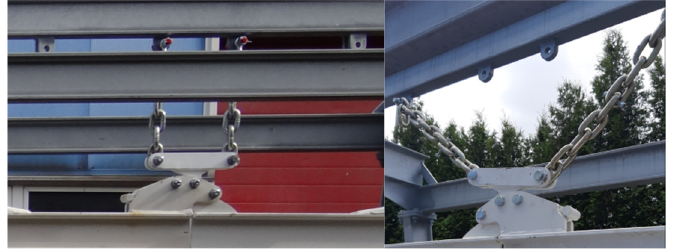
Figure 1. View of the test stand [2]. Each rail joint at the test stand was connected to a traverse, suspended from the stand frame with two chains. Successive pairs of chains were alternately installed vertically (perpendicular to the longitudinal axis of the rail) or they were deflected, forming the shape of the letter “V” (Figure 2).